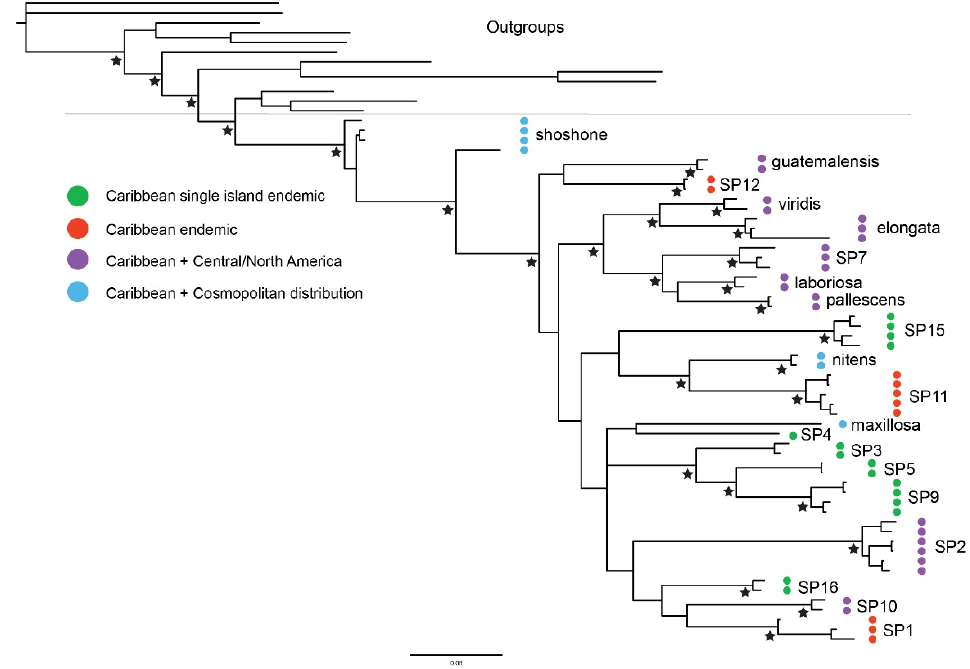
Figure 2. Species level Bayesian phylogeny of the Caribbean Tetragnatha based on COI and 28S. These species relationships support the Tetragnatha monophyly. Stars at nodes indicate Bayesian posterior probability values > 0.95.